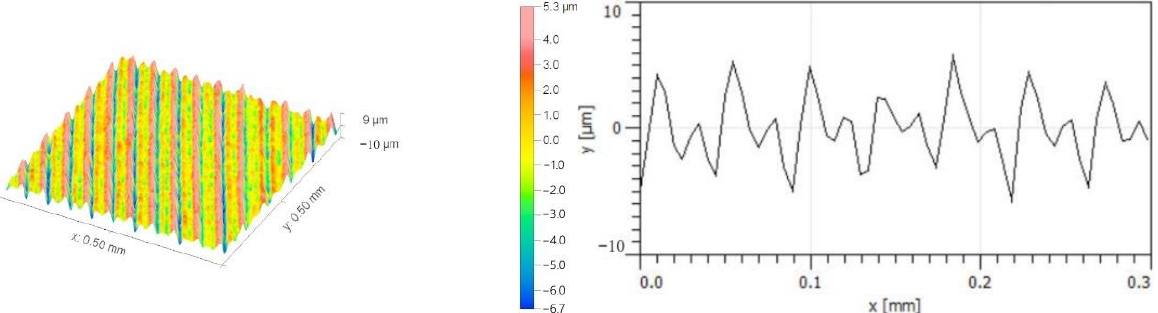
Figure 14. Micro-morphologies of machined surfaces with a cutting speed at v = 600 m/min.